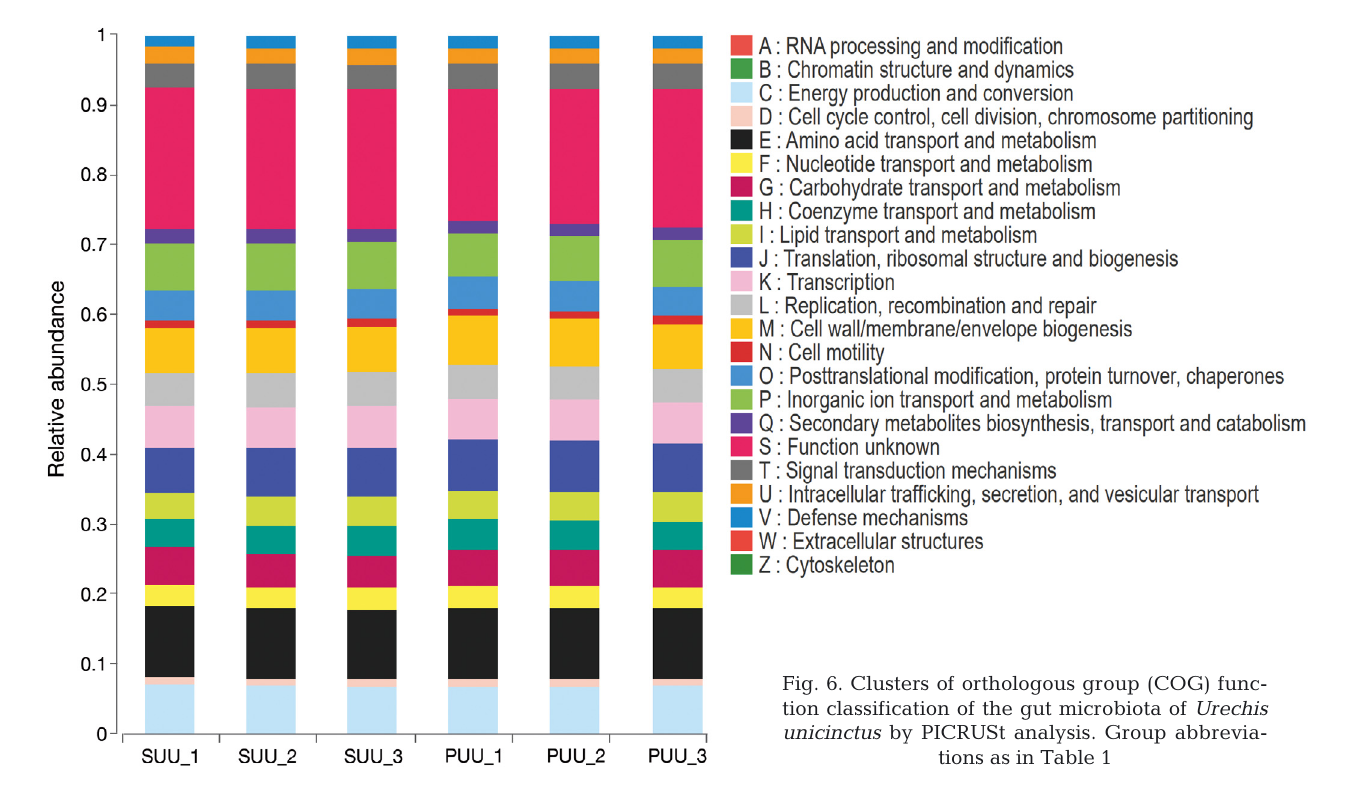
Fig. 6. Clusters of orthologous group (COG) func- tion classification of the gut microbiota of Urechis unicinctus by PICRUSt analysis. Group abbrevia- tions as in Table